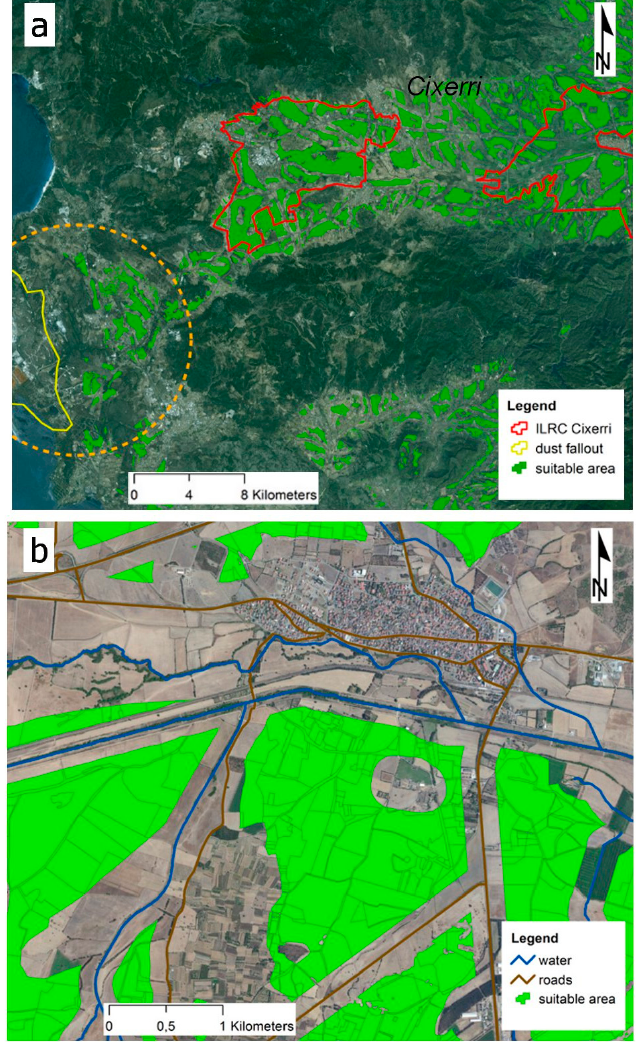
Figure 4. ( a ) Suitable marginal lands for Land Reclamation and Irrigation consortium ‘Cixerri’. Dashed circle indicates the most contaminated area; ( b ) Zoom-in on suitable areas nearby buffer zones around built-up areas, rivers and roads.